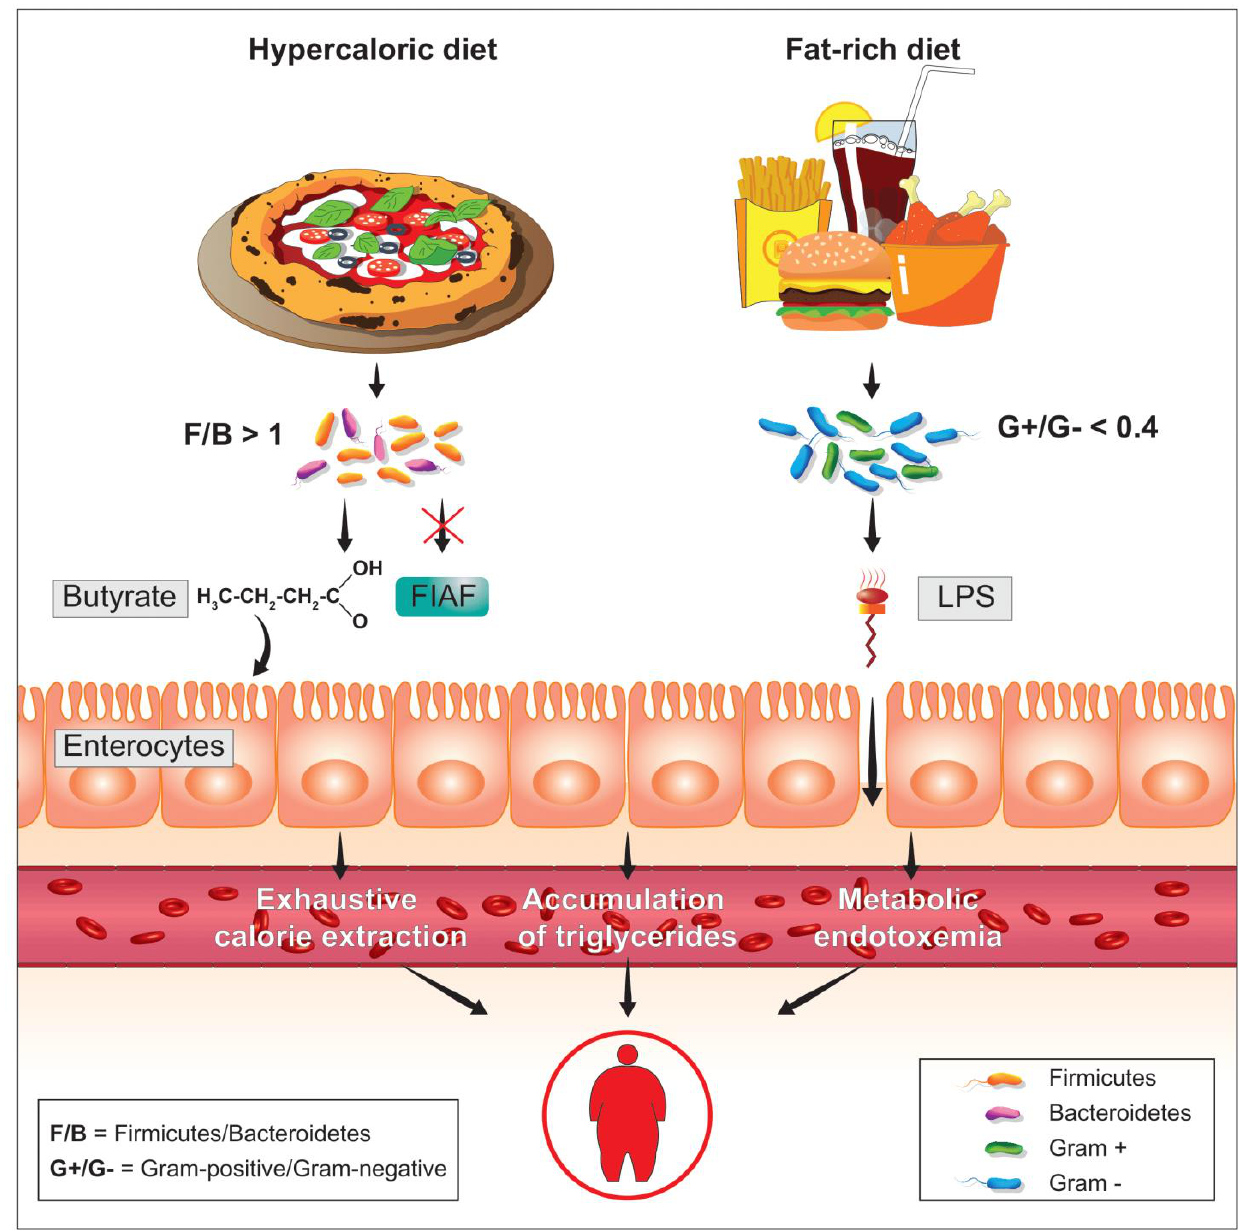
Figure 3. In relation to a high level of LPS, able to overcome the enterocyte barrier thus reaching the plasma circulation, phenomena such as metabolic endotoxemia can be generated, which are called into question to explain some forms of obesity coupled with metabolic syndrome. An increased percentage of Gram-negative bacterial species together with a condition of high intestinal permeability could favor this phenomenon.